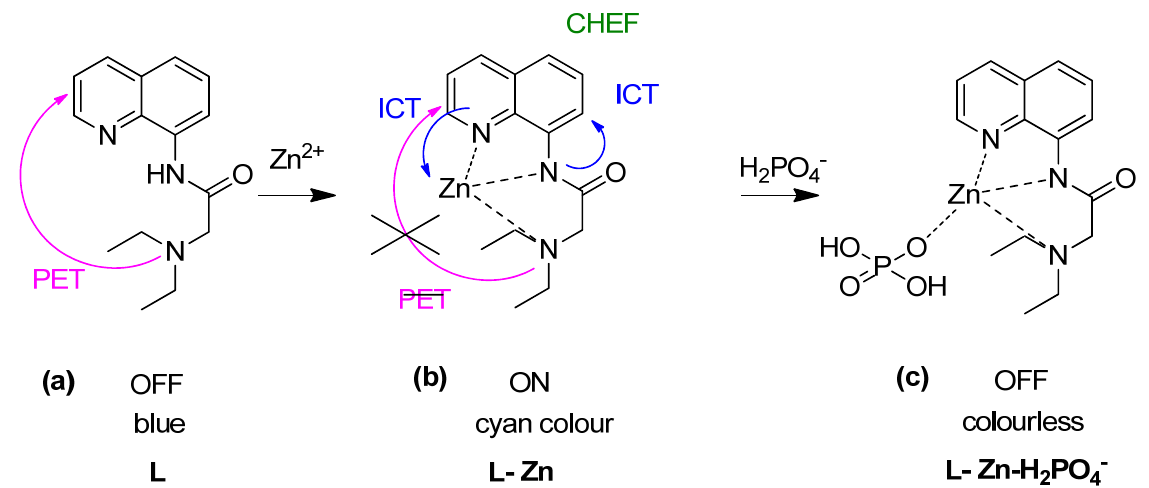
Figure 14. “Off–On–Off” fluorescent chemosensor for ( a ) L, ( b ) L-Zn, and ( c ) L-Zn- H 2 PO 4 − for relay recognition in an aqueous environment.